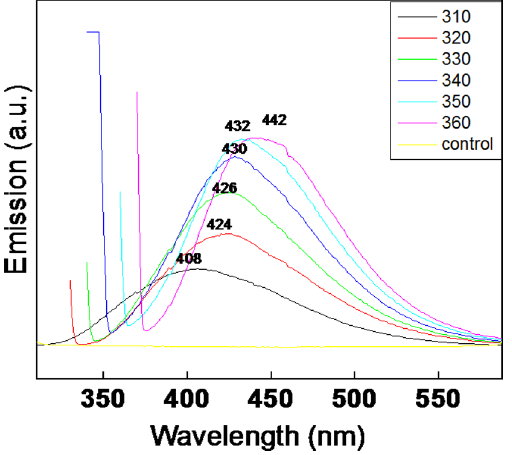
Figure 2. Photoluminescence spectrum of Fly-ash powder and bioleached silica nanoparticles (excited at different wave- lengths) obtained after 24 h reaction between Fusarium oxysporum and